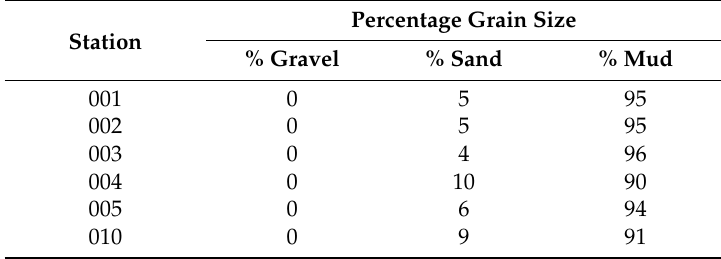
Figure 7. Sediment grain size data from van veen grab samples presented as percentage gravel, sand, and mud, overlaid on the 2017 100 kHz backscatter mosaic. Table 2. Seafloor sediment information from the van veen grab